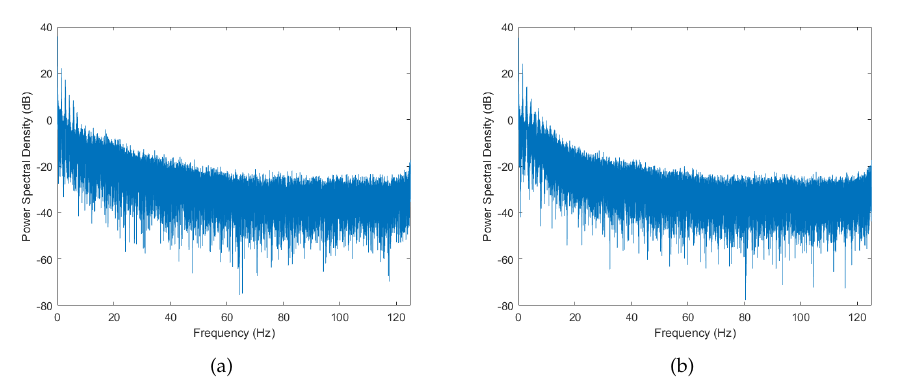
Figure 6. The power spectral density (PSD) of running activity. ( a ) Scenario 1; ( b ) Scenario 2.